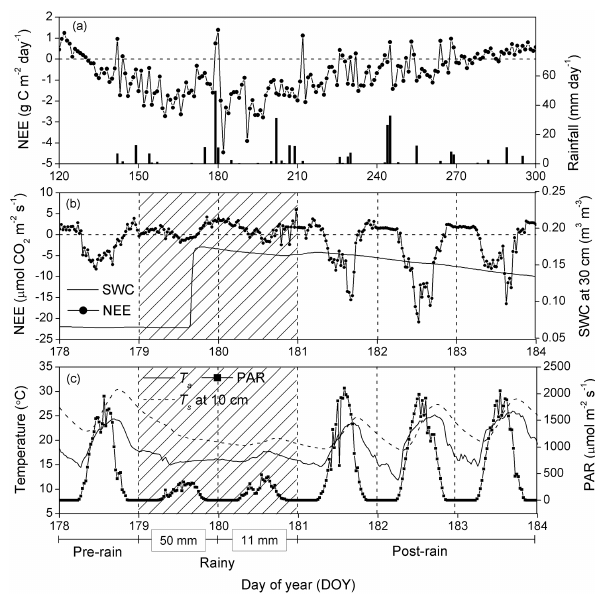
Figure 9. Pulses in daily net ecosystem CO 2 exchange (NEE) as related to rainfall events during the growing season (a) , and synoptic variations of half-hourly NEE, soil water content (SWC) at 30cm depth, air temperature (T a ) , soil temperature at 10cm depth ( T s ) and incident photosynthetically active radiation (PAR) before and after a selected rainfall event (b–c) . The horizontal dashed lines in (a) and (b) represent y = 0, and the vertical dashed lines in (b) and (c) separate each day. The shadow areas in (b) and (c) indicate rainy days. Rainfall was 50mm on DOY 179 and 11mm on DOY